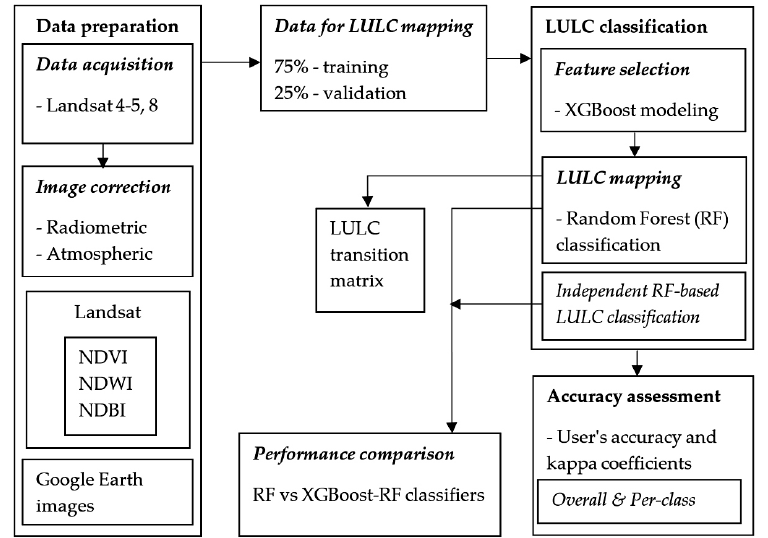
Figure 2. Flowchart showing overall methodology of this work.